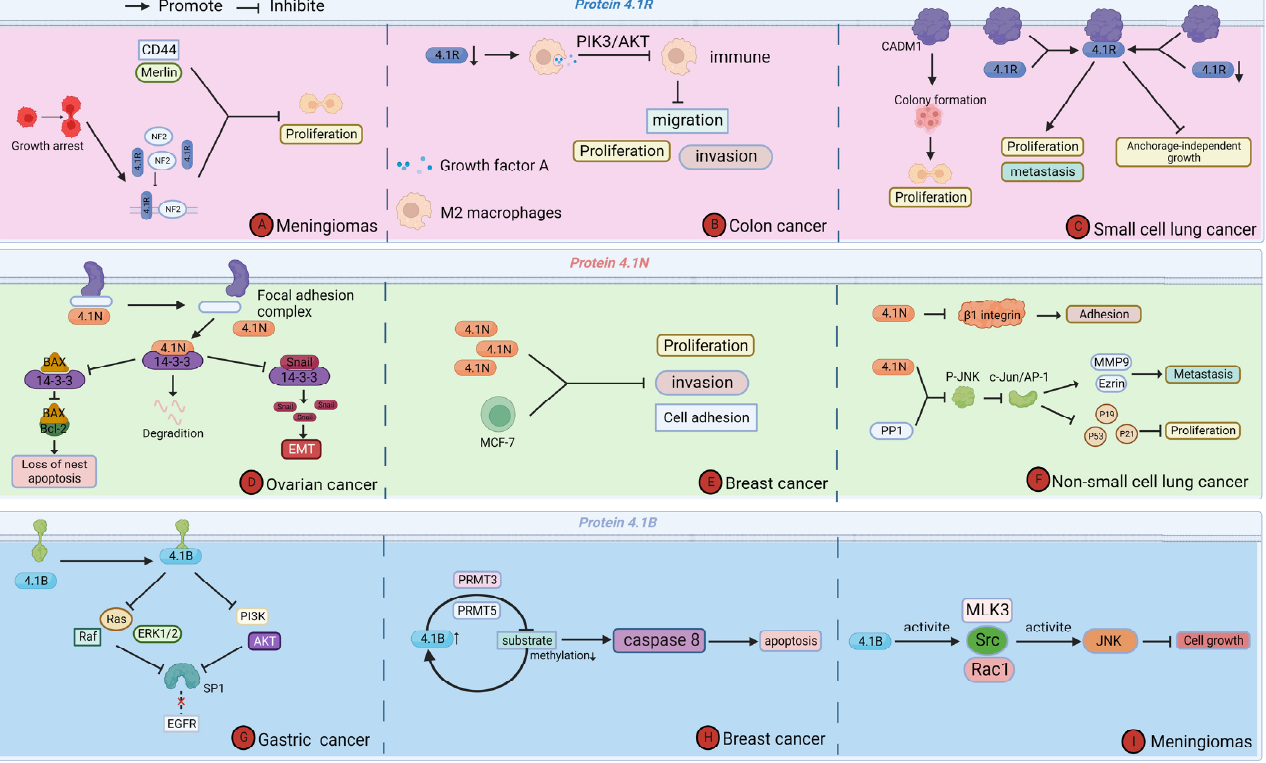
Figure 4. Function of Cytoskeleton Protein 4.1 in tumor microenvironment regulating cancer progression. ( A ) Protein 4.1R affects the proliferation of meningioma. ( B ) Protein 4.1R affects the proliferation, migration, and invasion of colon cancer. ( C ) Protein 4.1R affects the proliferation and metastasis of small cell lung cancer. ( D ) Protein 4.1N affects the apoptosis and degradation of ovarian cancer. ( E ) Protein 4.1N affects the proliferation, invasion, and cell adhesion of breast cancer. ( F ) Protein 4.1N affects the proliferation, metastasis, and adhesion of non-small cell lung cancer. ( G ) Protein 4.1B affects the progression of gastric cancer. ( H ) Protein 4.1B affects the apoptosis of breast cancer. ( I ) Protein 4.1B affects the cell growth of meningioma.